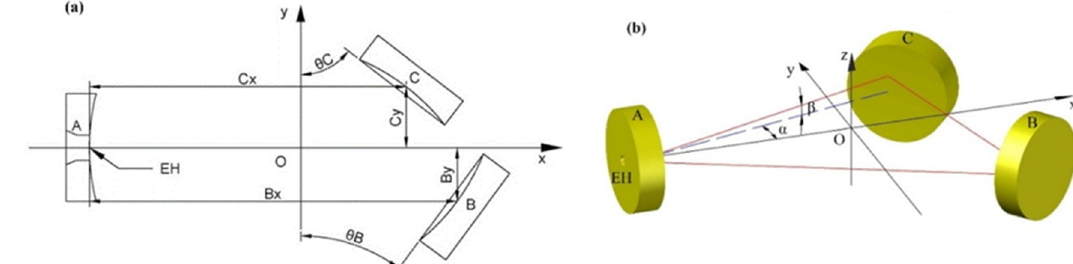
Figure 1. ( a ) The structural parameters in the XOY plane and ( b ) the three-dimensional CAD model of the three-mirror-based gas cell.